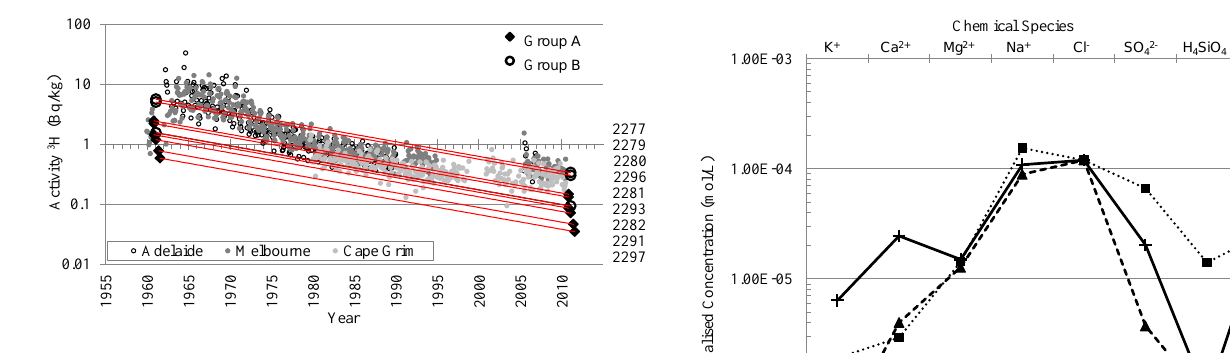
Figure 4. Tritium decay curves for the nine samples with detectable tritium levels (Table 2); each curve is calculated for 50 years of decay. The atmospheric tritium values are shown also to indicate possible recharge times; unpublished rainfall data from ANSTO. The precision of the tritium dates varies; sample 2297 was recharged in 1960 or earlier, whereas sample 2281 was recharged from 1975-95 or during 1960 and earlier.